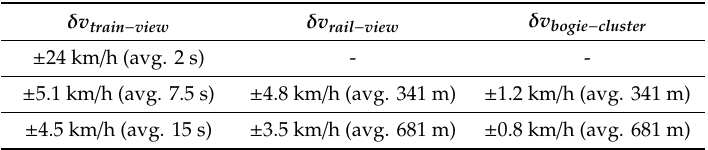
Table 1. Standard deviation of the velocity for train tracking of an ICE 4 train moving at 160 km / h using di ff erent signal processing and averaging